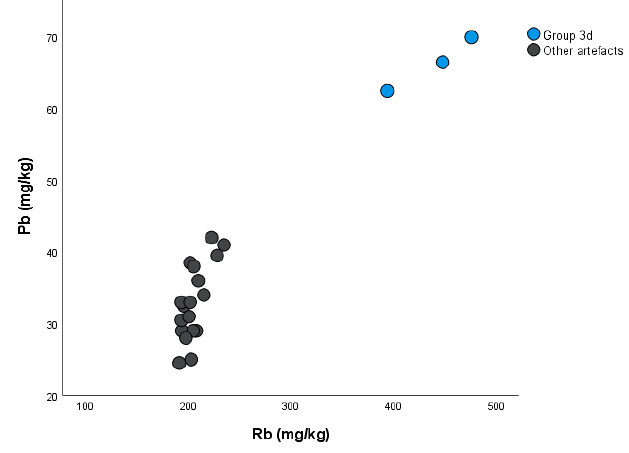
Figure 9. Rb vs. Pb scatterplot showing obsidian artefacts and Bingöl A geological samples. Group 4, consisting of six artefacts, is separated for its higher Ca and Ti values in Figure 6. In the Ba vs. Zr scatter plot, our data for Group 4 are compared to published values in order to define the geological source of the samples (Figure 10). Group 4 artefacts have a Ba content ranging from 317 to 431 ppm, while their Zr content is between 268 and 291 ppm. Therefore, the element composition of this group corresponds to Bingöl B source.